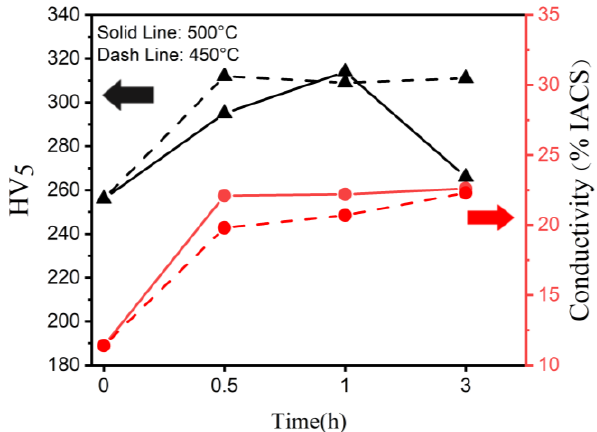
◦ C from a 40% cold rolling for 0.5, 1, and 3